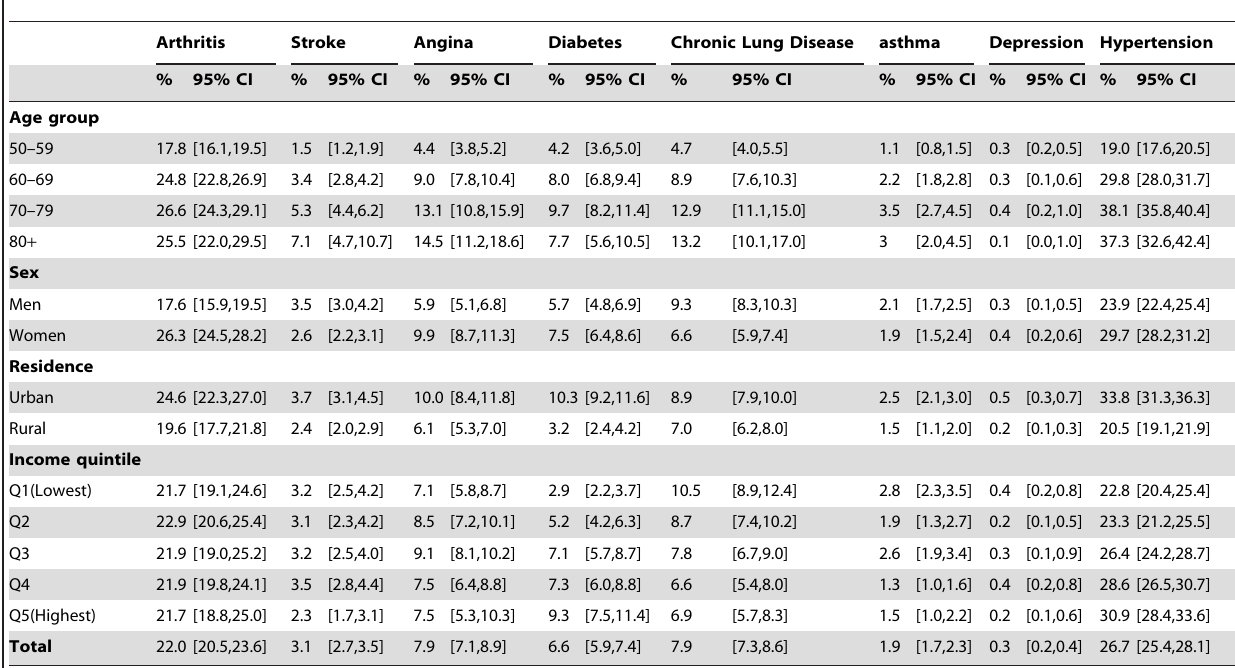
Table 2. Self-reported Prevalence of Major Chronic Conditions Among older adults aged 50 and older in China, by selected sociodemographic characteristics.